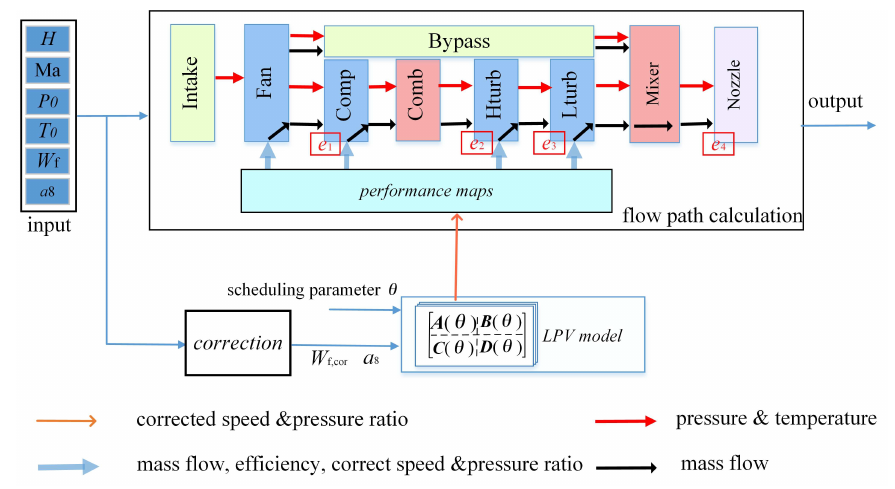
Figure 2. Computational flow diagram of turbofan engine